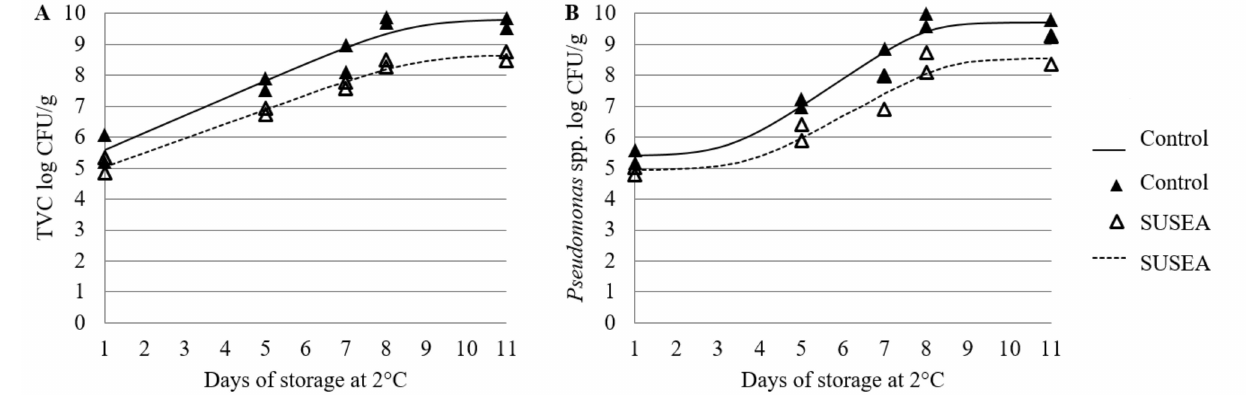
Figure 2. Microbial growth models of ( A ) Total Viable Counts (TVC) and ( B ) Pseudomonas spp. in gilthead seabream fillets stored isothermally at 2 ◦ C for the Control (untreated) and SUSEA (Treated) fillets. Continuous lines represent the statistical fit of the Baranyi